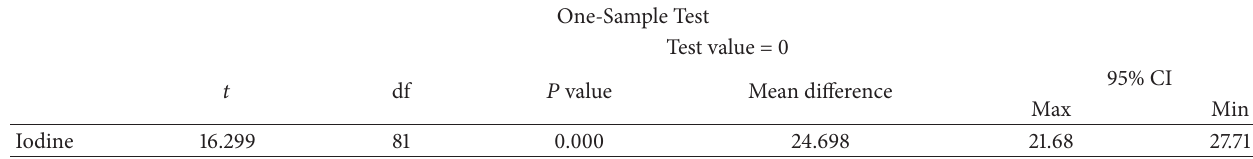
Table 4: Comparing average iodine values in salt samples (ppm). One-Sample